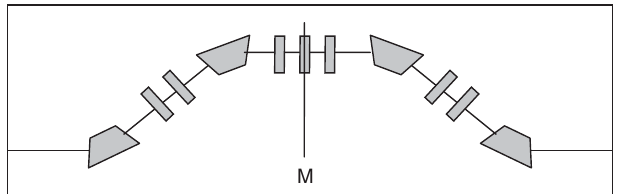
FIG. 9. Geometry of C -chicane bunch compressor.